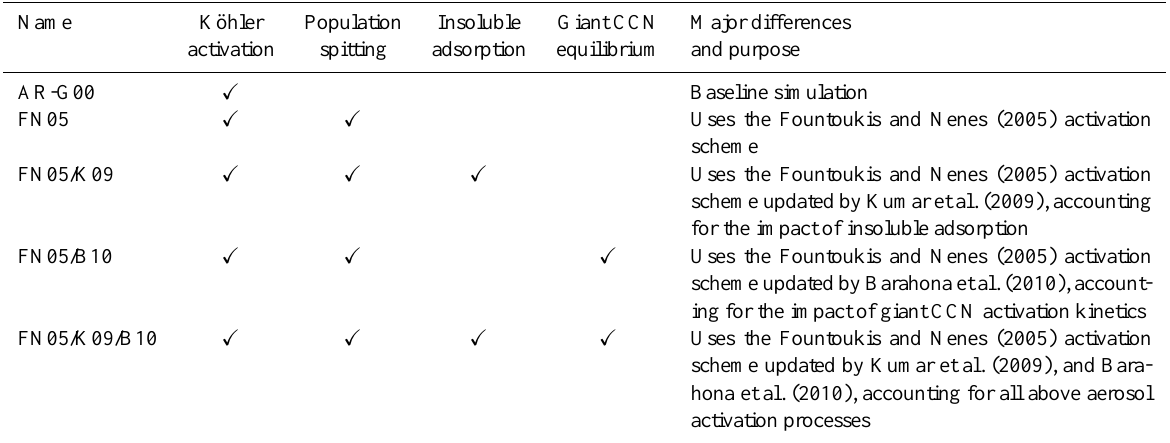
Table 1. The CESM/CAM5-MAM7 simulations performed in this